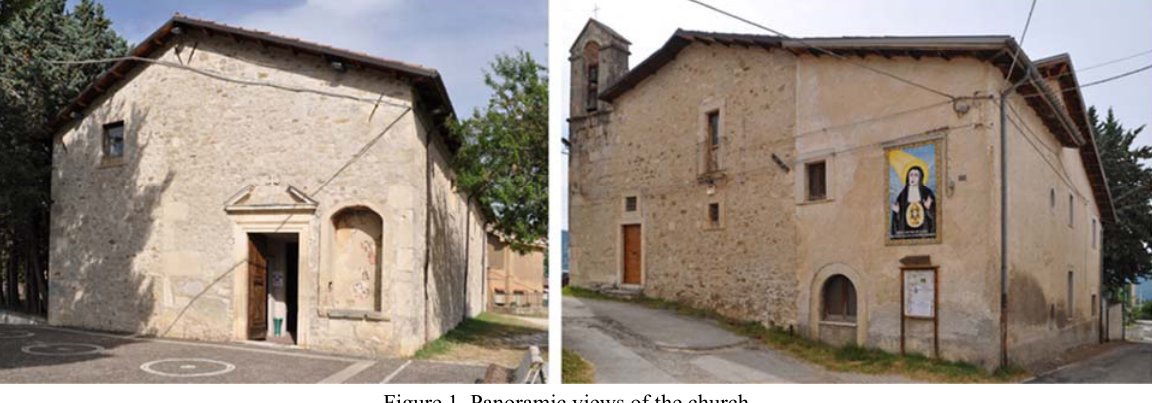
Figure 1. Panoramic views of the church